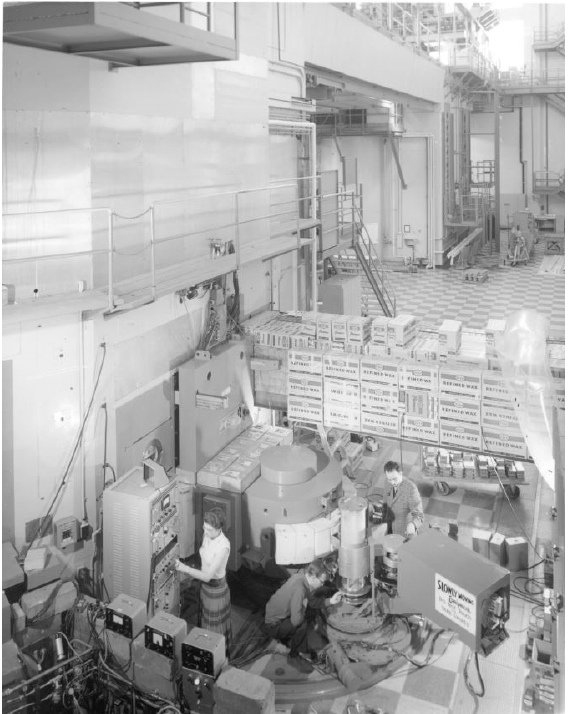
Figure 19. Photograph of the C5 spectrometer at the NRU reactor in the early 1960s. Margaret Elcombe, Brian Powell, and Dave Woods are setting up a low-temperature experiment. (Courtesy of Atomic Energy of Canada Limited.).